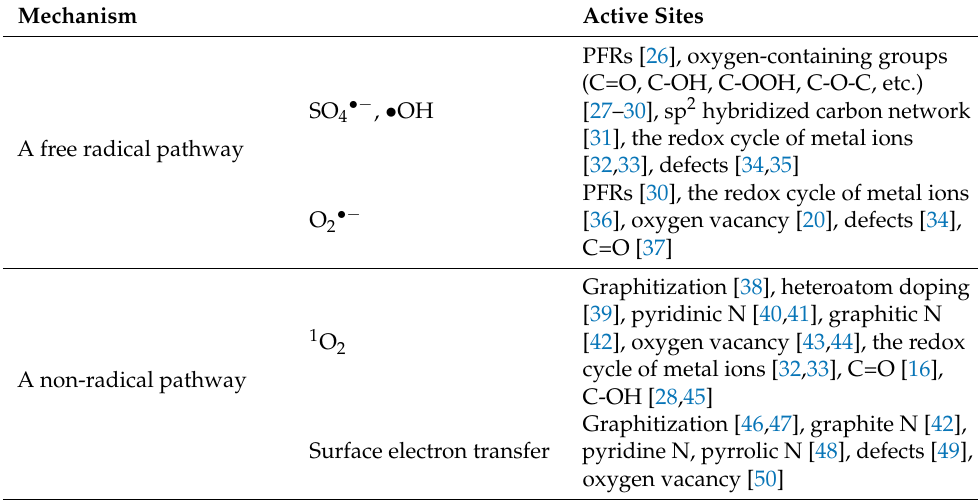
Table 2. Active sites on biochar catalysts for PS activation to remove